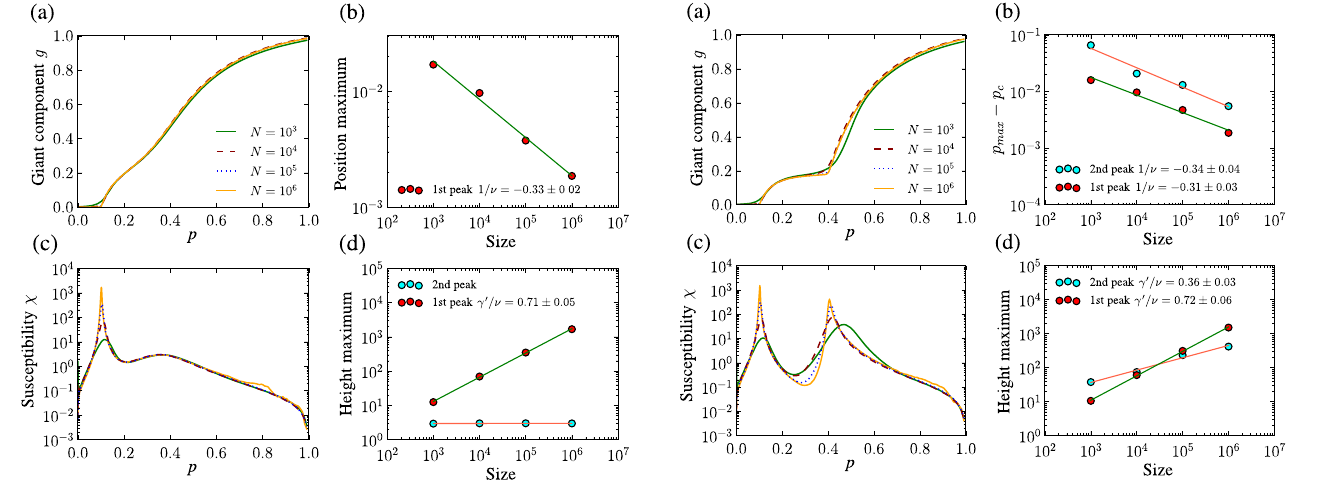
¯ 10 and the periphery k c ¼ and height max